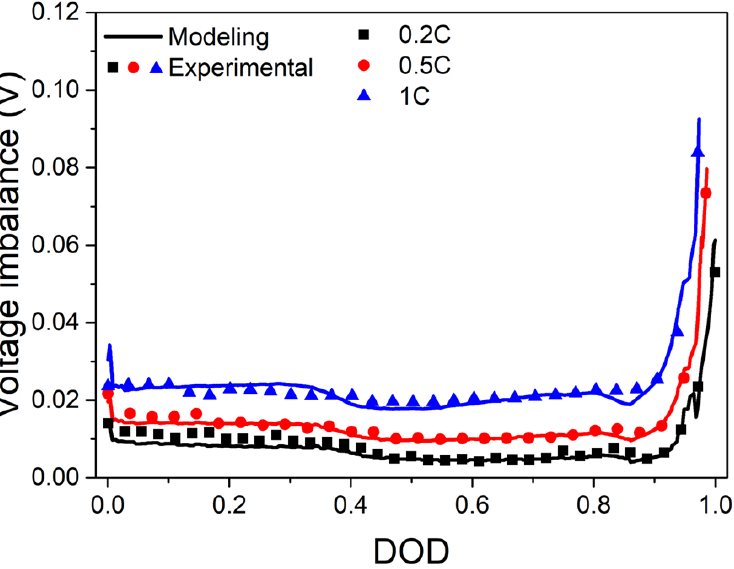
Figure 11. Comparison of modeling and experimental results of the difference between the maximum and minimum voltages between LIB strands according to DOD . The solid lines denote modeling results and symbols are the experimental data.